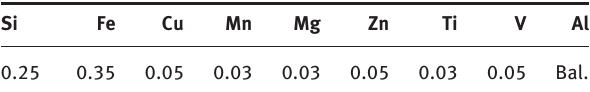
Figure 3. Gleeble-1500 thermal simulator automatically